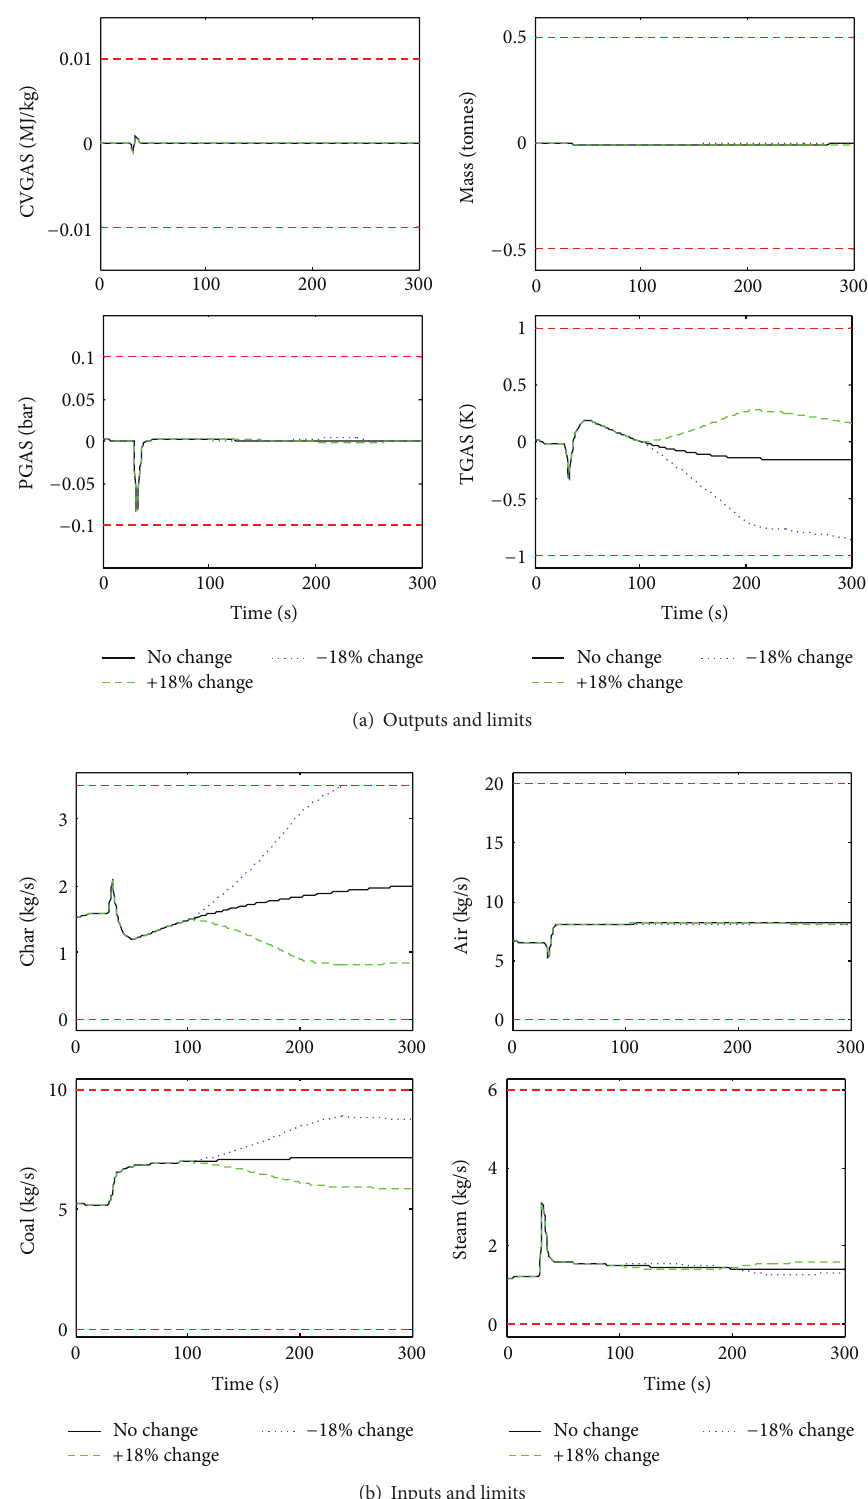
Figure 9: Response to step disturbance at 0%